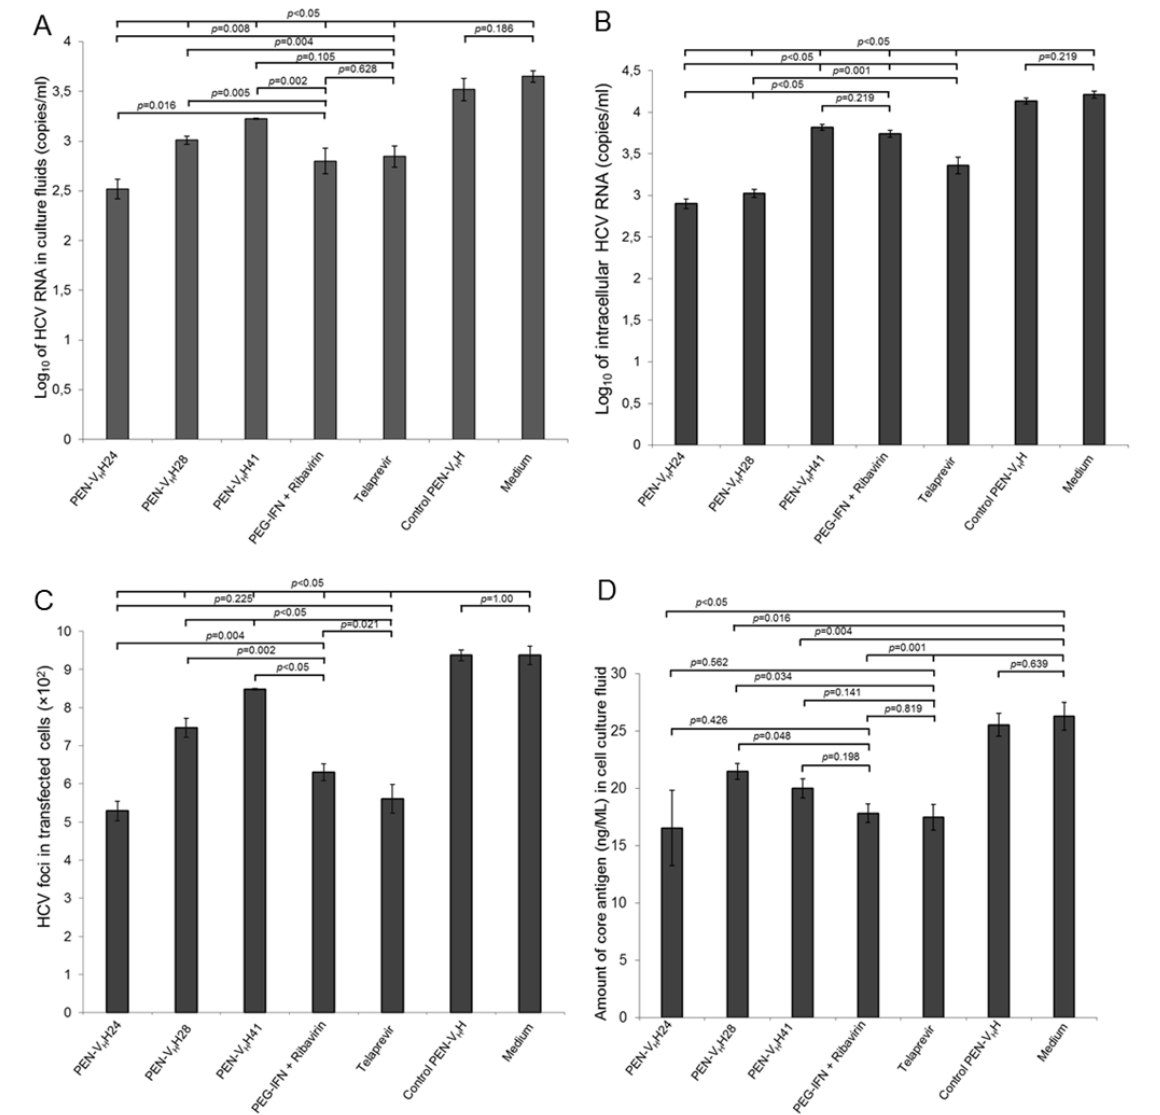
Figure 6. The numbers of the hepatitis C virus (HCV) 5’ UTR RNA, infectious particles and core antigen in the culture supernatants and/or inside the transfected cells treated with the protease specific-transbodies and controls. ( A ) and ( B ) Amounts of HCV RNA in the culture supernatants and inside the transfected Huh7 cells treated with the HCV protease specific-transbodies (PEN-V H H24, PEN-V H H28 and PEN-V H H41), PEG-IFN- α + ribavirin, telaprevir, irrelevant (control) transbody and medium alone, respectively; ( C ) The numbers of the HCV foci in the transfected cells treated with the HCV protease specific-transbodies and controls as determined by foci assay; ( D ) Amounts of the HCV core antigen in culture supernatants of HCV RNA transfected cells after receiving different treatments. p < 0.05 is significantly